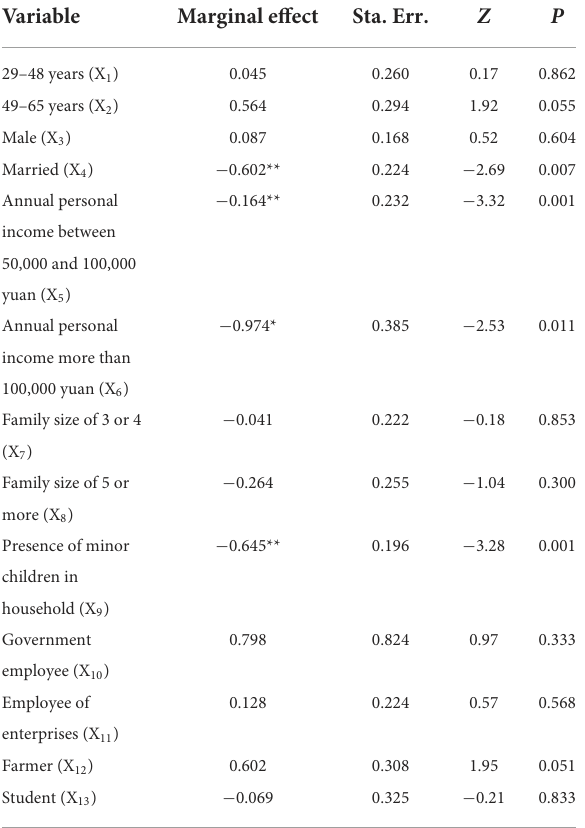
TABLE 5 Marginal effect of individual characteristic variables.